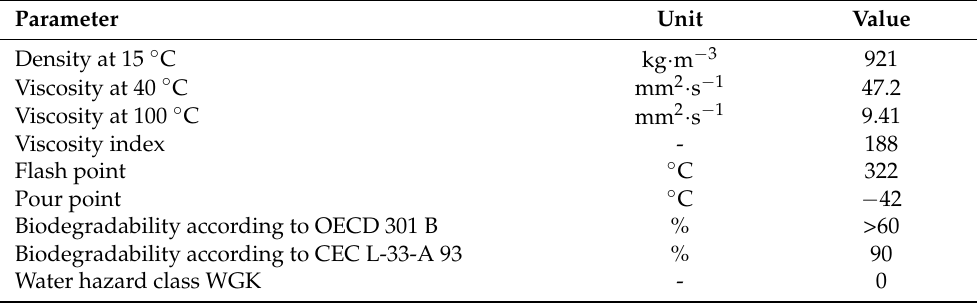
Table 1. Basic properties of the tested transmission–hydraulic fluid Shell Naturelle HF-E 46.